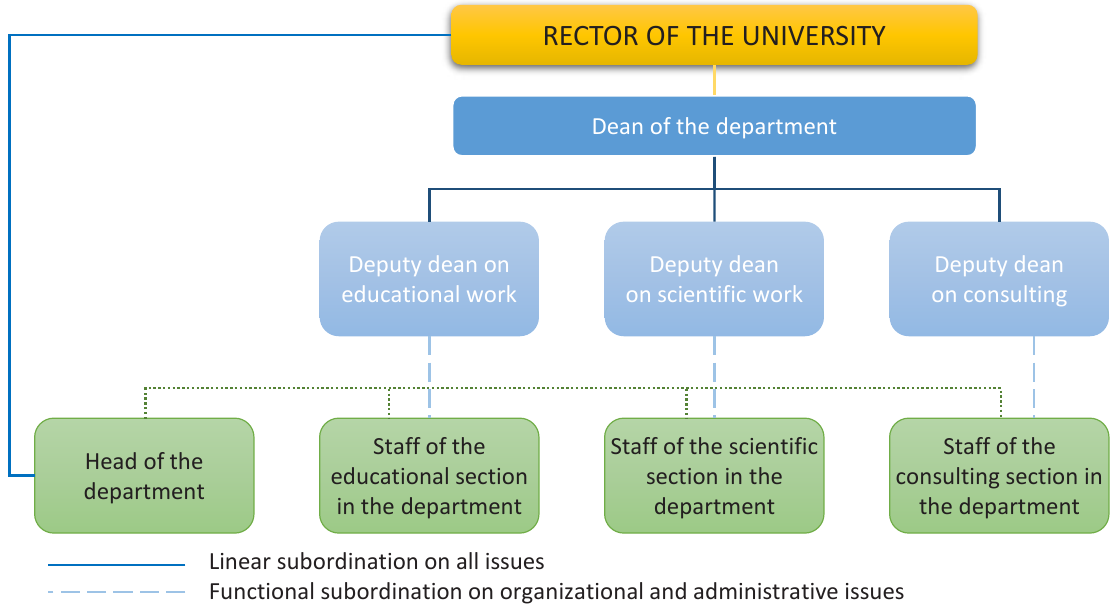
Figure 2. Scheme of the matrix management structure in the internal system of providing